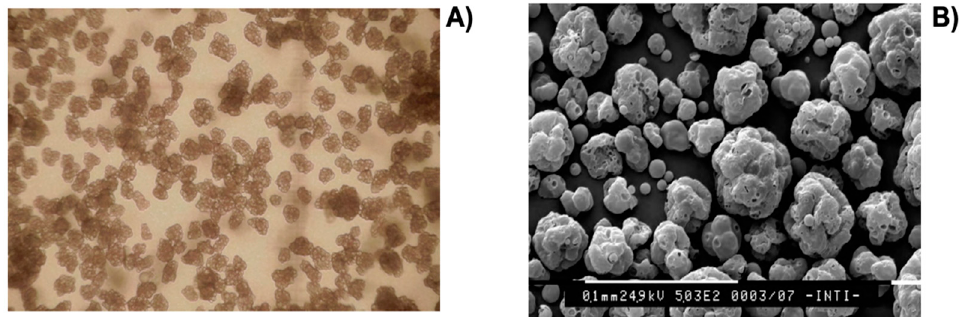
Figure 27. ( A ) Optical micrographs of gelatin microcapsules containing citronella essential oil (100x magnification) and ( B ) SEM microphotographs of spray-dried microcapsules containing citronella essential oil (500× magnification) [70]. Table 6. Overview of essential oil microencapsulation, methods, wall materials, and indust- rial